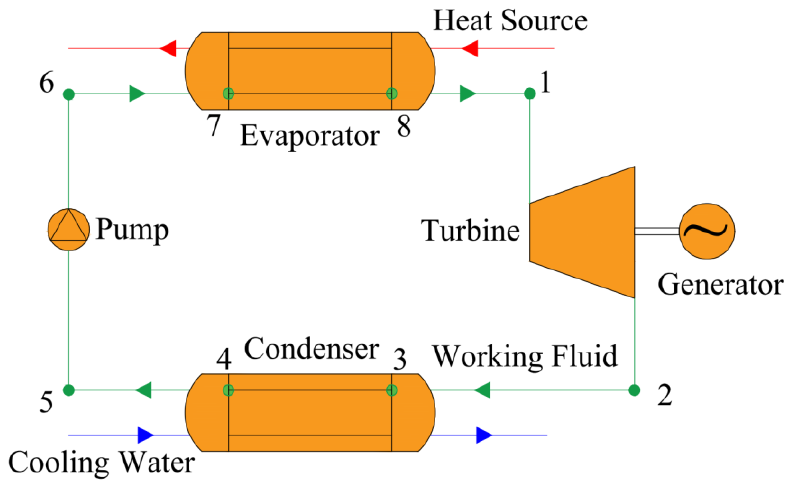
Figure 1. Schematic diagram of the ORC.